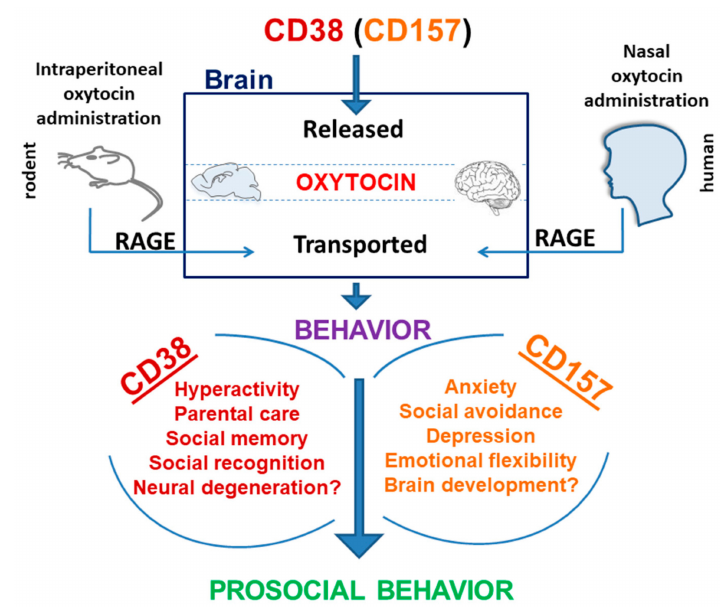
Figure 5. Scheme of CD38- and CD157-mediated pathways related to social behavior. The scheme shows the possible molecular mechanisms for increases in brain oxytocin (OT). One is OT release due to CD38 and CD157. Another is owing to receptor for advanced glycation end-products (RAGE)-dependent transport of OT into the brain. CD38- and CD157-dependent social behaviors are listed. The increased OT may trigger prosocial